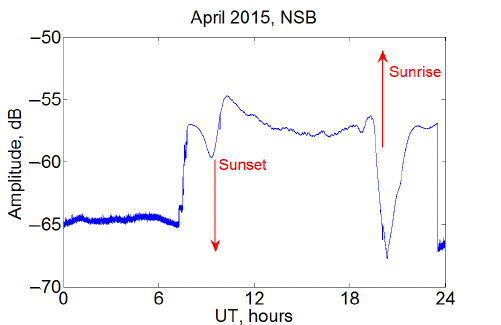
Figure 5. Example of average daily signal variation for NSB station, April 2015, JJI transmitter.